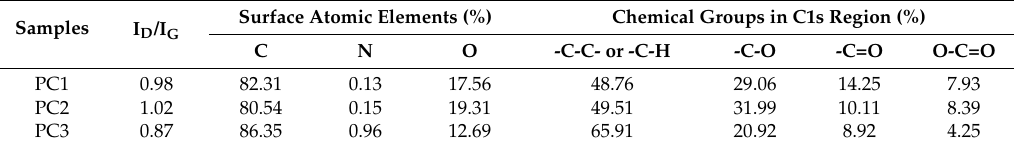
Figure 4. XRD patterns ( a ) and Raman spectra ( b ) of the porous carbons (PCs) samples. Table 2. The relative compositions of surface atomic elements and chemical groups, and I D /I G values of the porous carbon samples (PC1, PC2, PC3).